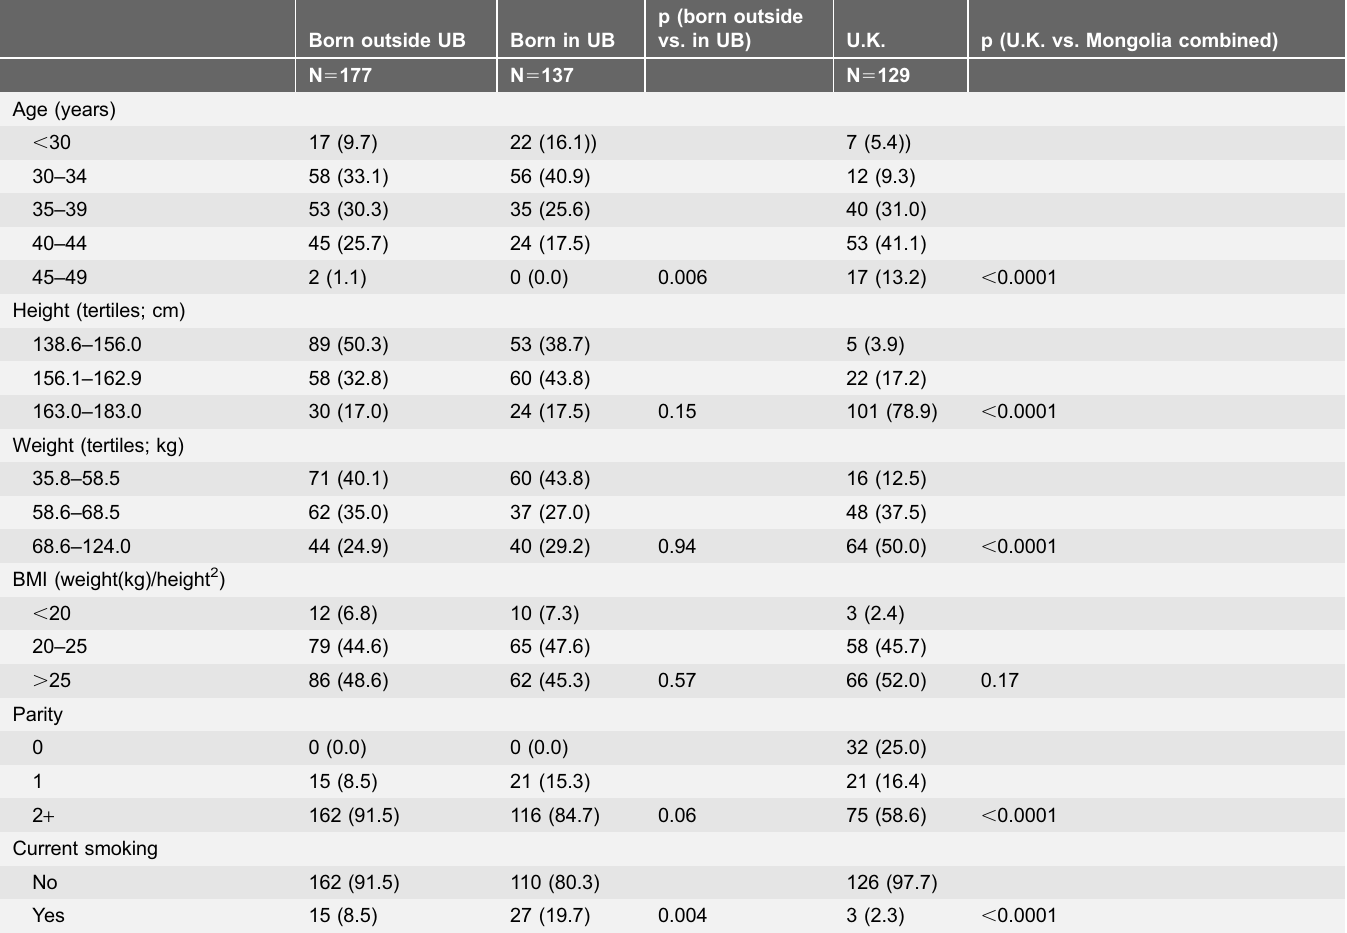
Table 1. Characteristics of Mongolian and U.K.